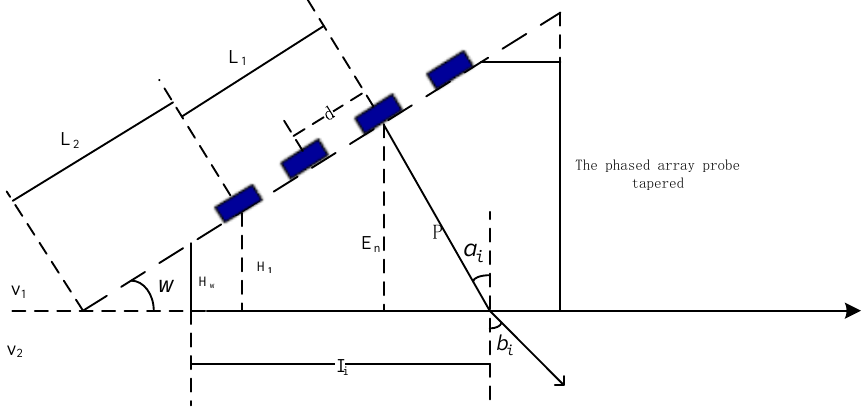
Figure 3. Calculation of the delay time of a phased-array probe wedge.